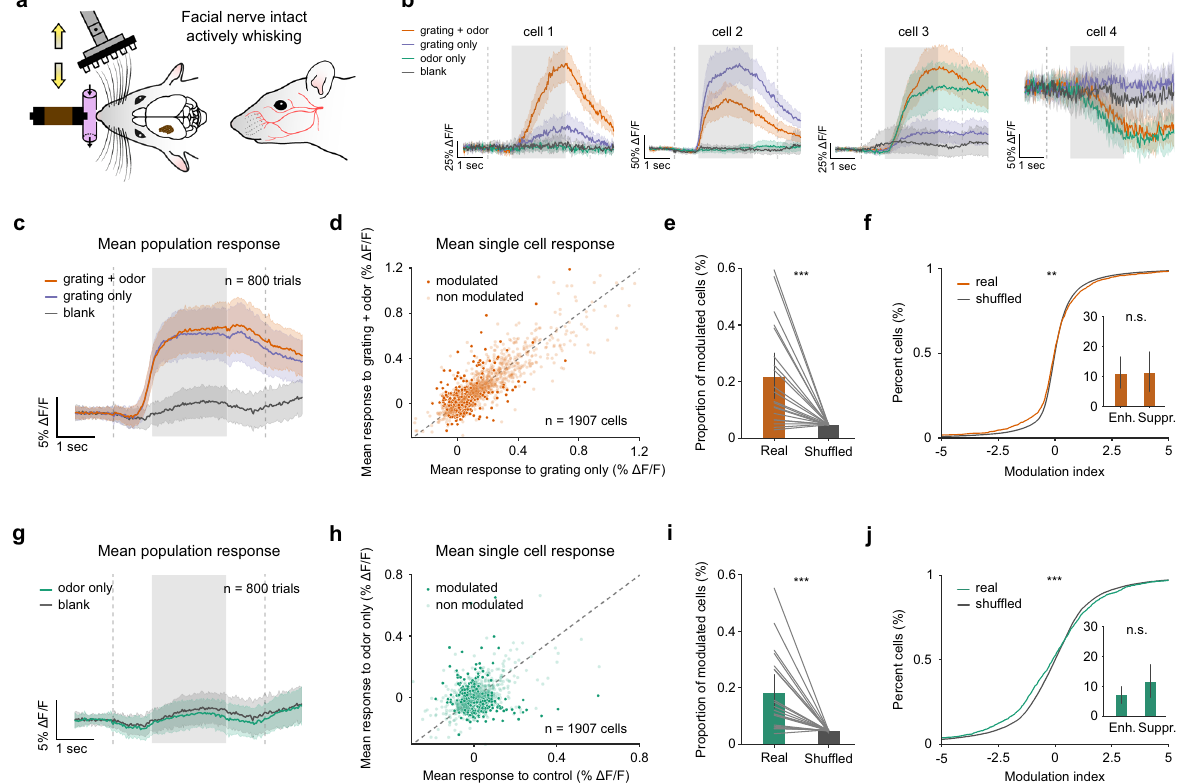
Fig. 2 Odor-induced responses of L2/3 barrel cortex cells in the active stimulation context. a Schematic of the stimulation condition with facial nerve intact. Gratings were brought in contact with the whiskers. b Average Δ F/F for four example neurons displaying diverse odor responses. c – f Responses to grating + odor stimulation compared with grating only. Stimuli were grouped into four categories: grating + odor (orange), grating only (blue), odor only (green), and control (gray). c Population averages to grating + odor trials (both orientations and both odors grouped together; orange) and grating-only trials (both grating orientations grouped together; blue); average to blank (gray) is shown for comparison. d Scatter plot of mean Δ F/F to grating + odor versus grating only for 1907 neurons. Neurons plotted in dark were signi fi cantly modulated ( P < 0.05, Mann – Whitney U test). Dashed line indicates diagonal. e Proportion of modulated neurons across sessions compared with shuf fl ed conditions (21.71% (14.69, 29.58) for real data; 4.84% (4.80, 4.87) for shuf fl ed data; P = 2 × 10 − 5 ; Wilcoxon signed-rank test, n = 20 sessions). f Cumulative distribution of modulation index for grating + odor versus grating alone ( P = 0.109; Kolmogorov – Smirnov test, n = 1907 cells). Inset: proportion of enhanced and suppressed cells (mean enhanced = 10.35% (5.60, 15.77); mean suppressed = 11.36% (6.06, 17.60); P = 0.793; Wilcoxon signed-rank test, n = 20 sessions). g – j Response to olfactory stimulations alone compared with control. g Population averages to odor-only trials (green) and control (gray) (mean of odors only trials = 0.57% Δ F/F ( − 0.64, 2.01), mean of blank trials = 1% Δ F/F (0.28, 1.81) computed over stimulation epoch; P = 0.394; n = 800 trials from 20 sessions; Mann – Whitney U test). h Same as ( d ) but for odor versus blank. i Same as ( e ) (18.34% (12.78, 24.76) for real data; 4.89% (4.84, 4.94) for shuf fl ed data; P = 1 × 10 − 5 ; Wilcoxon signed-rank test, n = 20 sessions). j Same as ( f ) ( P = 2.3 × 10 − 4 ; Kolmogorov – Smirnov test; inlet: mean enhanced = 6.97% (4.48, 9.98); mean suppressed = 11.36% (6.10, 17.52); P = 0.398; Wilcoxon signed-rank test, n = 20 sessions). Error bars and bands indicate 95% con fi dence intervals for the mean throughout the fi gure. All tests are